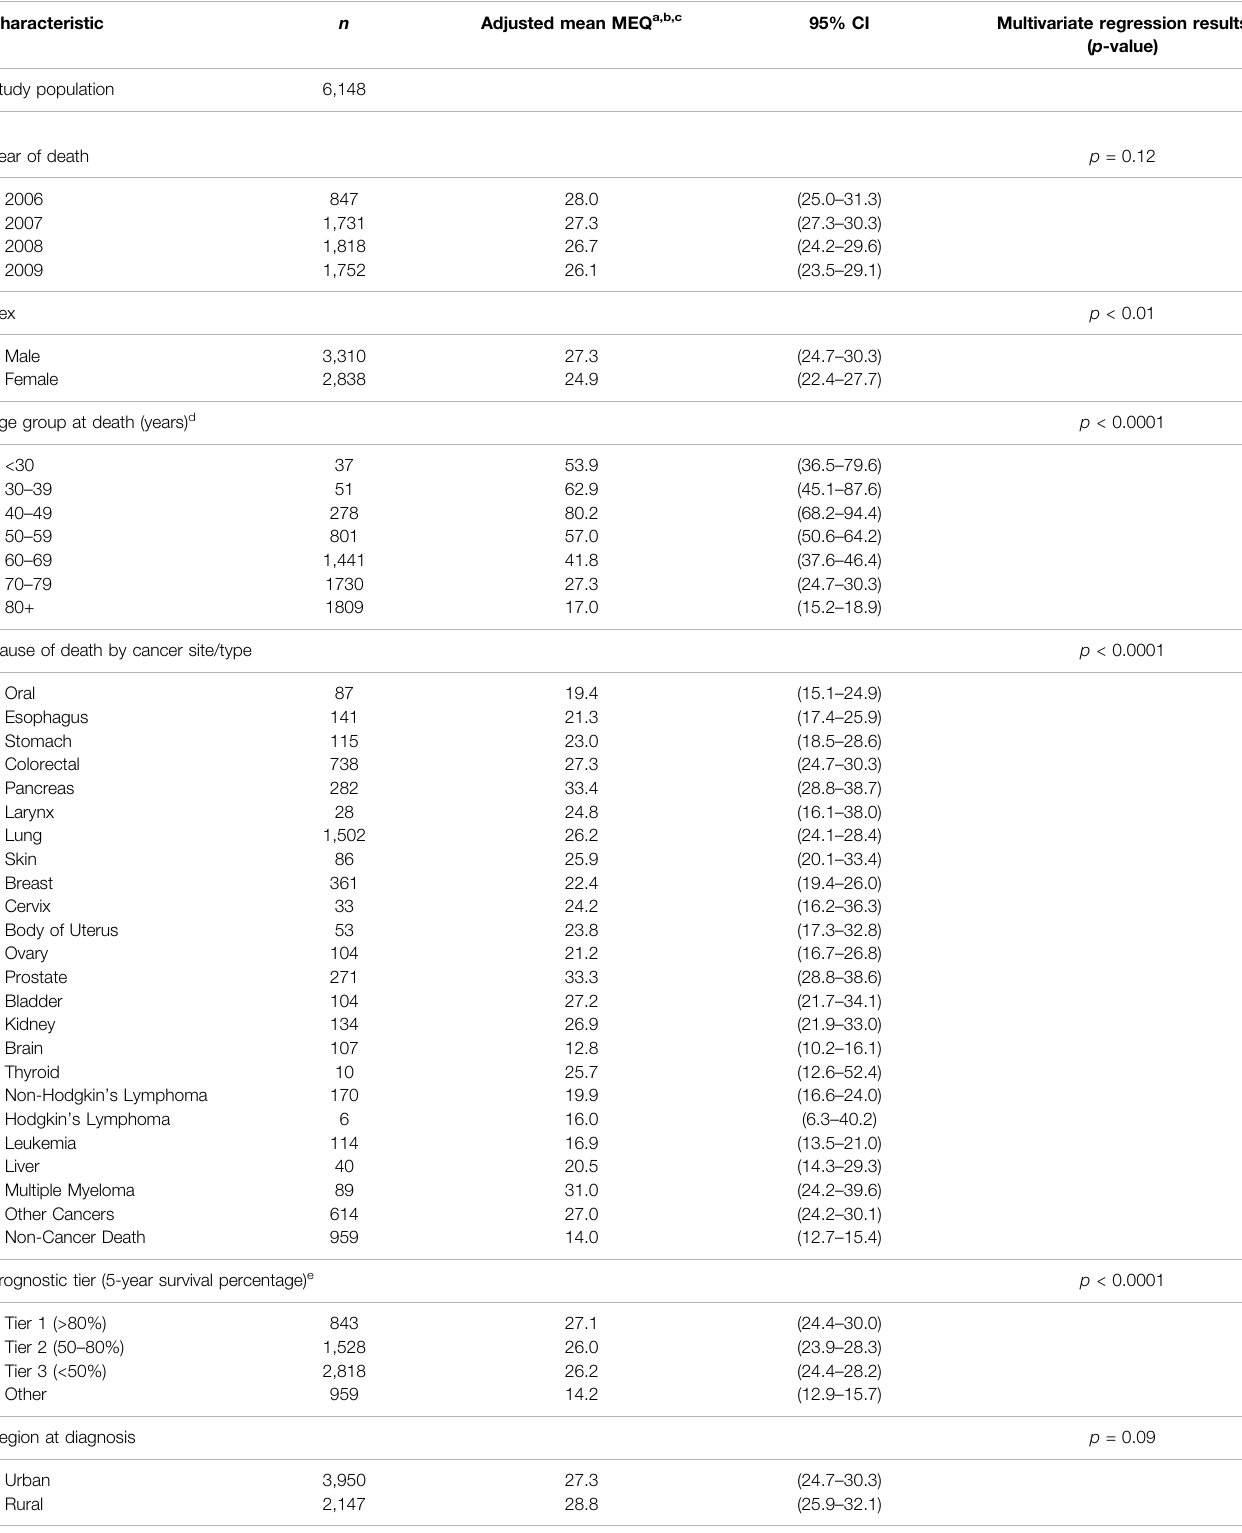
TABLE 4 | Adjusted average morphine equivalents per day (MEQ) dispensed per person among the Nova Scotia end-of-life cancer study population by selected demographic and clinical characteristics from 2005 – 2009 ( n =